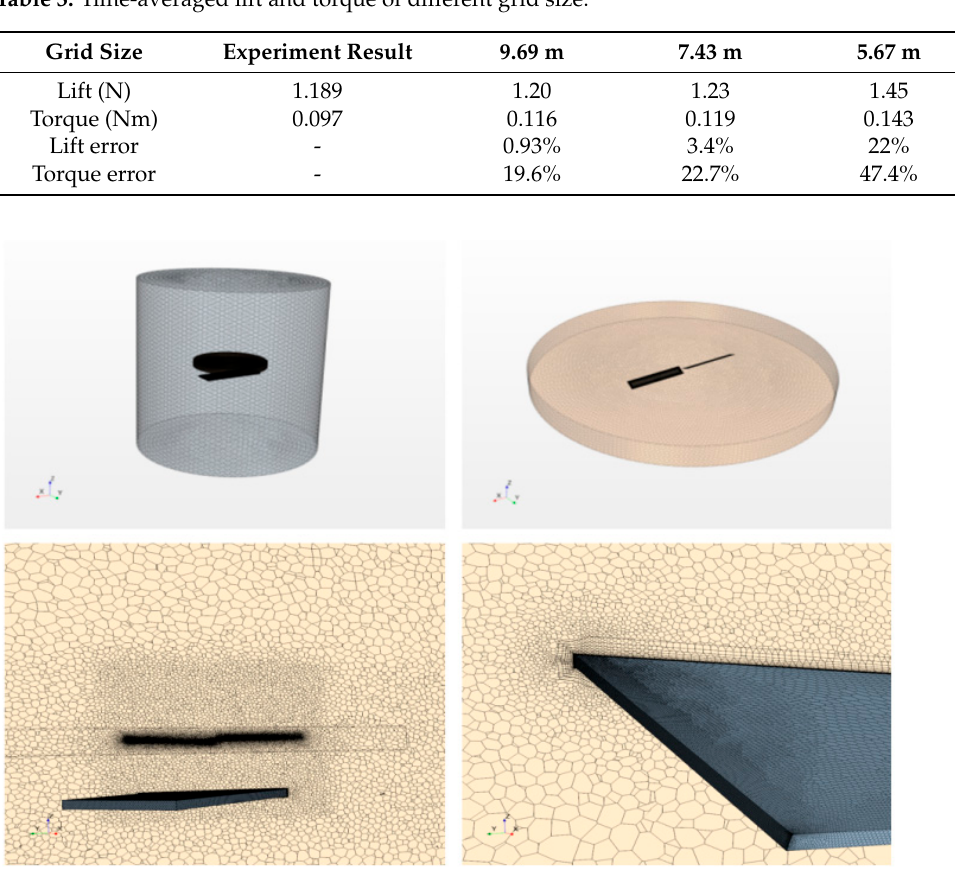
Figure 3. Detailed grid of the simulation.